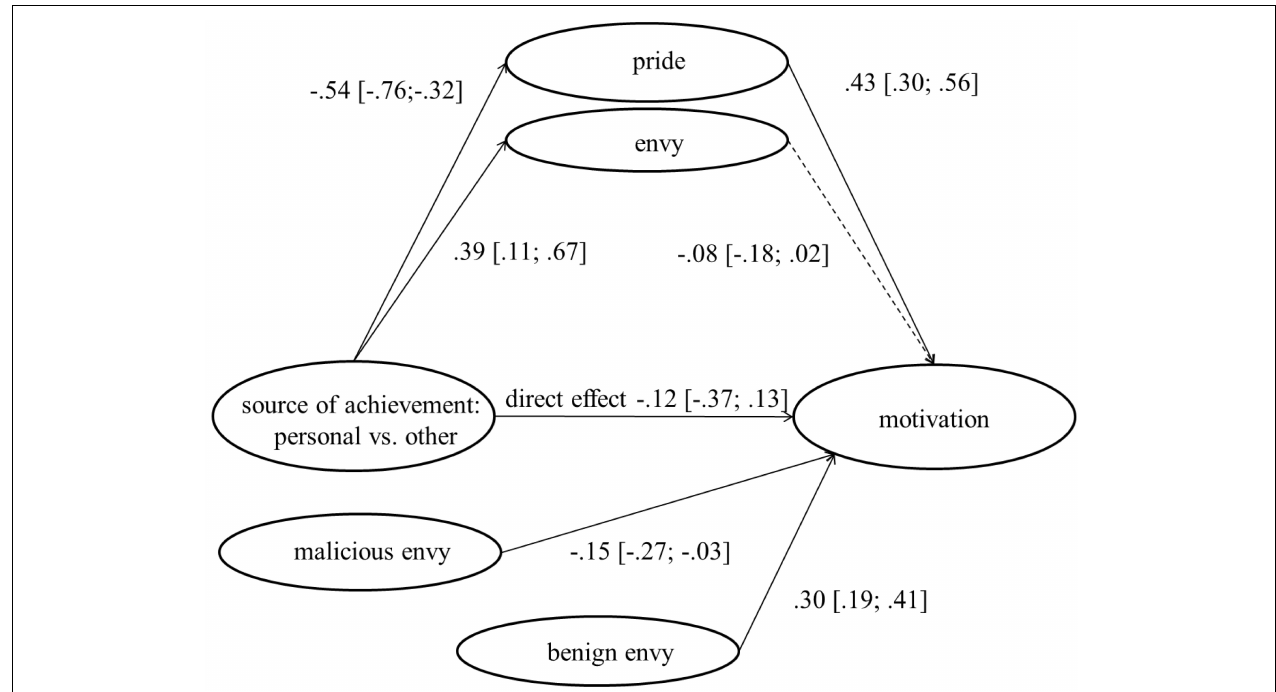
FIGURE 1 | Effects of achievement source on emotions and motivation, controlling for effects of trait benign and malicious